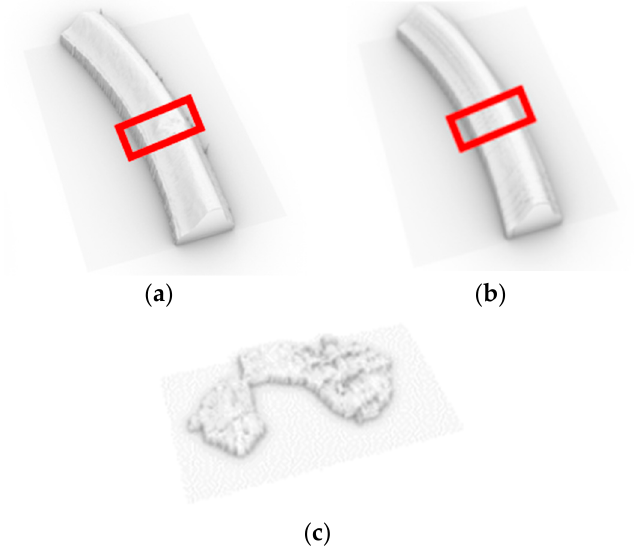
Figure 23. A tiny defect on the O-ring’s surface ( a ) Model of photometric stereo produce M P ; ( b ) smooth model M S ; ( c ) subtracting result on defect candidate area.